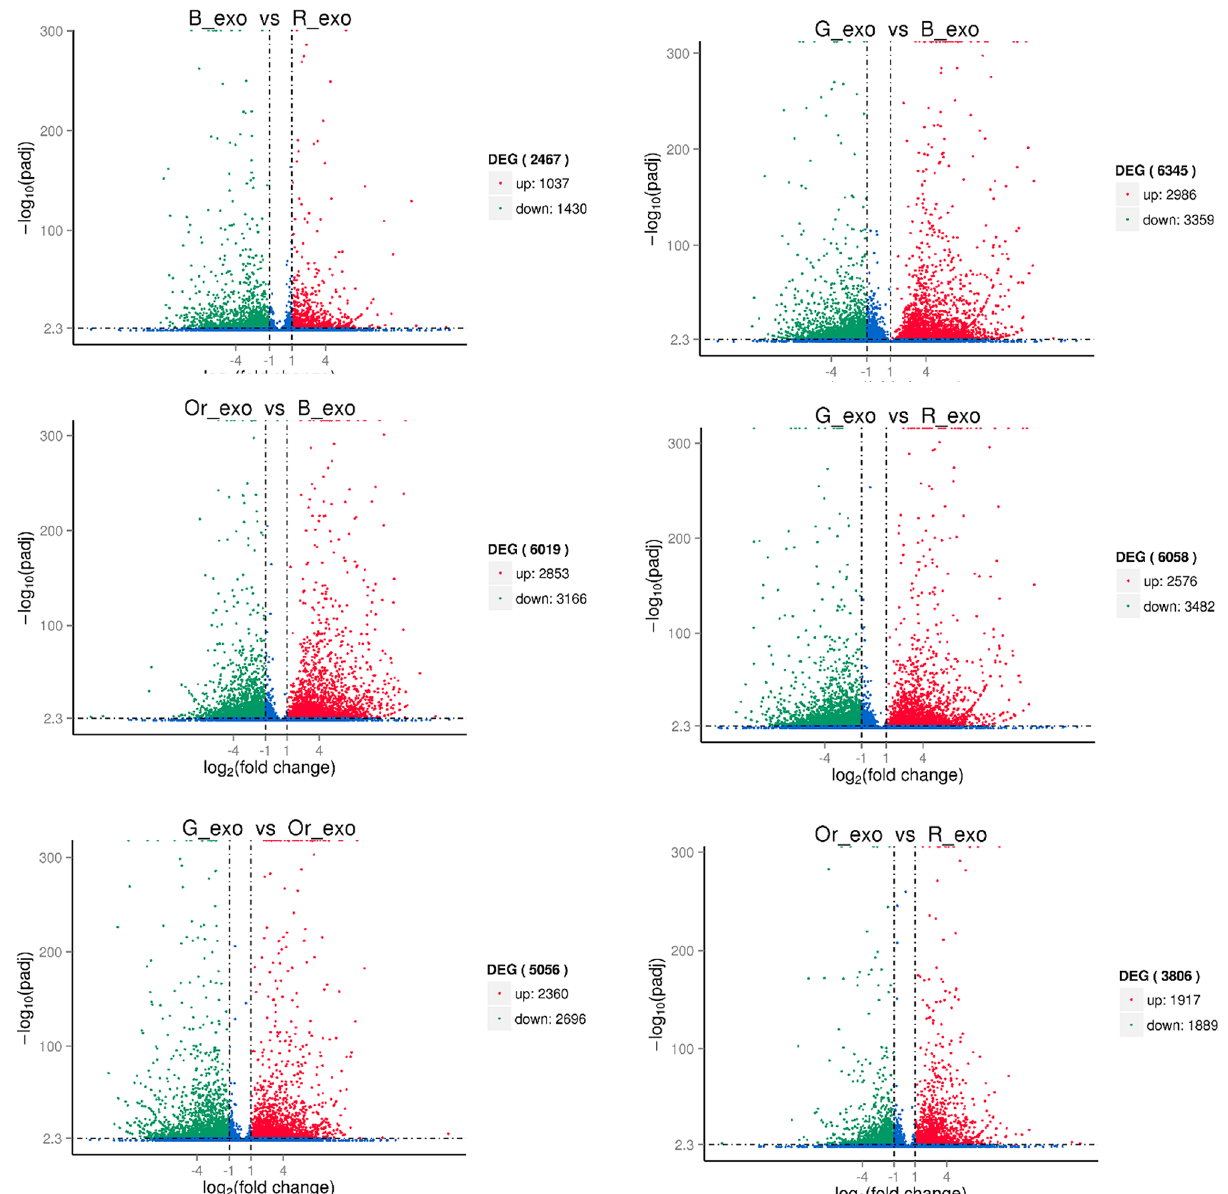
type and R_exo = red mature nigrescent